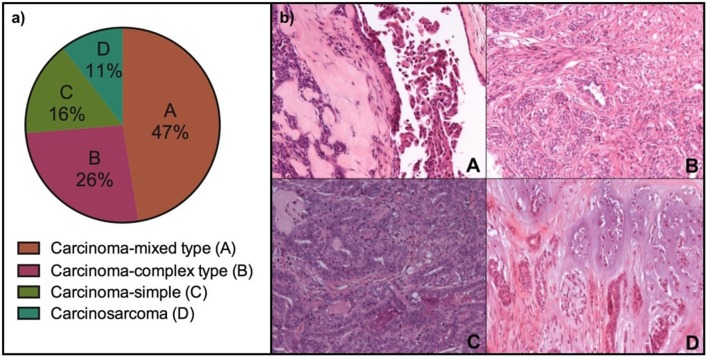
Histological subtypes of malignant mammary gland tumors analyzed by PET/CT in eight female dogs. (a) Percentage of tumors by histologic subtype; (b) Representative photomicrographs of the four histologic subtypes by HandE staining, 20x (A, Carcinoma-mixed type; B, Carcinoma-complex type; C, Carcinoma-simple; and D, Carcinosarcoma).